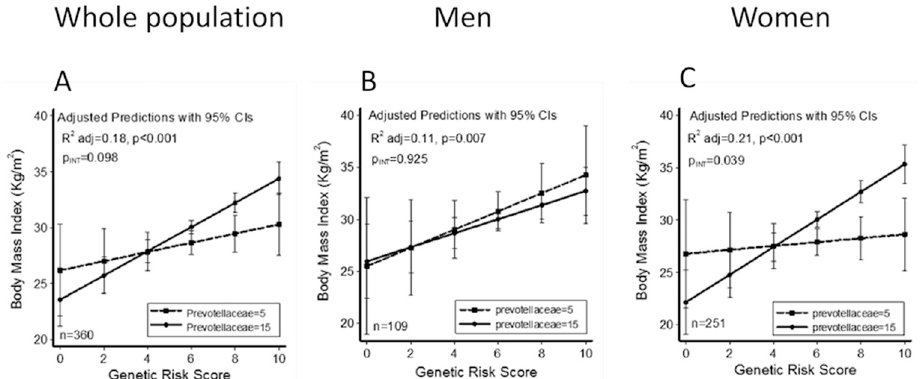
Figure 6. Predicted values of BMI in all population studied ( A ), men ( B ) and women ( C ) according to the Genetic Risk Score (GRS) calculated with 5 (dash line and square dots) and 15 (solid line and circle dots) relative abundance of Prevotellaceae, using linear regression models adjusted for age, sex, physical activity and energy intake, showing association between relative abundance of Prevotellaceae family and